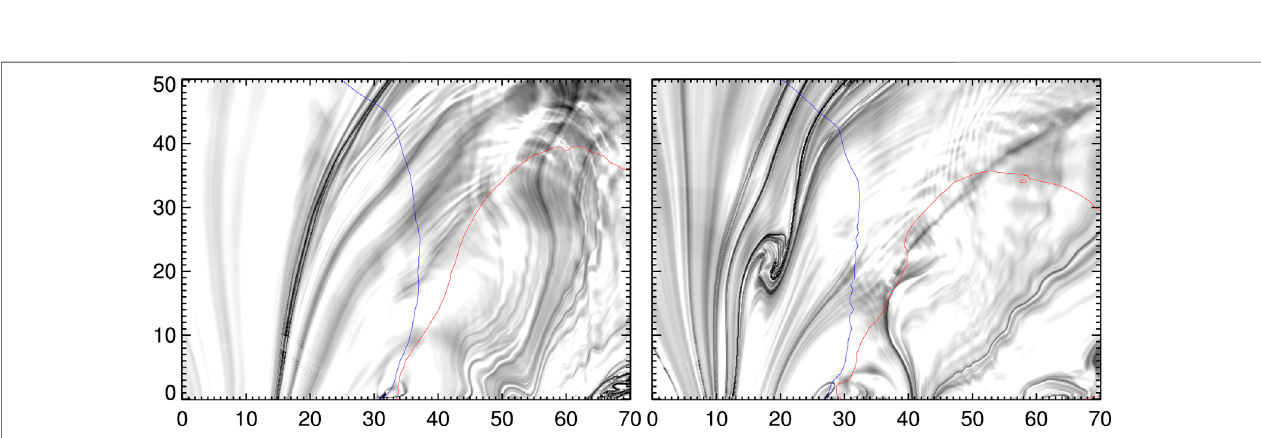
FIGURE 9 | Inverse maps of Log( Q ) in the vertical slice placed across the sigmoid in the AR 12371 as shown in Figure 5 . Contours of B z ( ± 80 G, red/blue curves) are over plotted. QSLs of large Q-values (black) are boundaries of magnetic domains enclosing the twisted- fl ux core about the PIL.